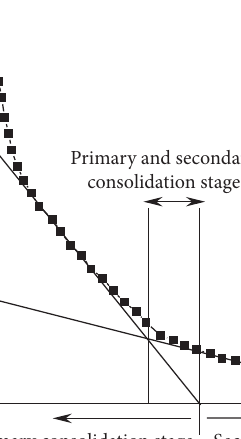
� 592.2kJ/m 3 and σ � 1500kPa.